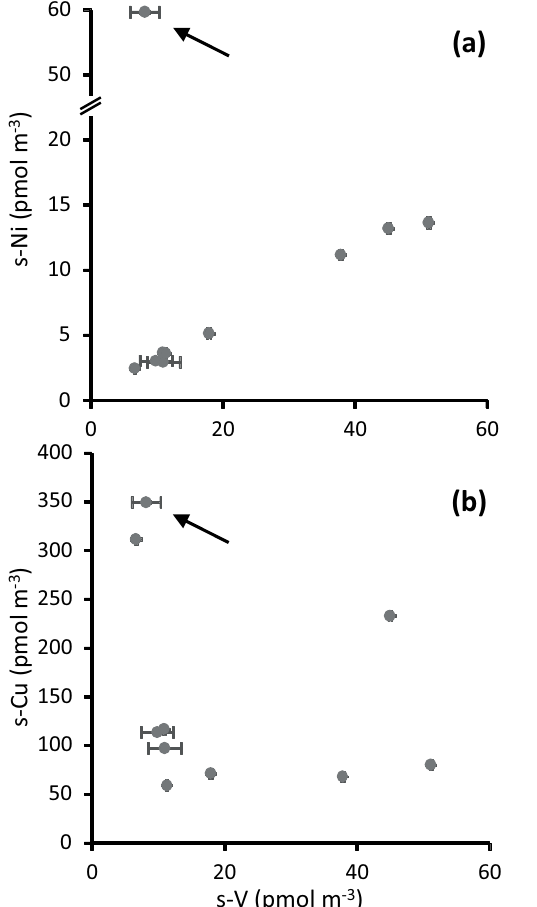
Figure 5. Plots of (a) soluble nickel (s-Ni) and (b) soluble cop- per (s-Cu) against soluble vanadium (s-V) concentrations in M91 aerosol samples. Sample TM09 is indicated by an arrow in both panels. Note the change in y axis scale in (a) .